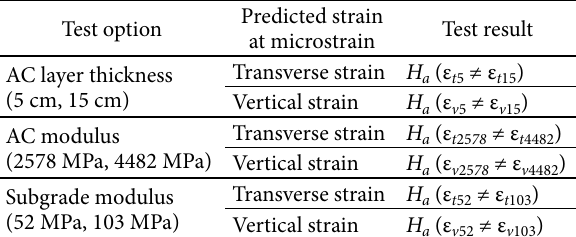
Table 3. The ANOVA test results ( α = 0.05) for predicted strain Test